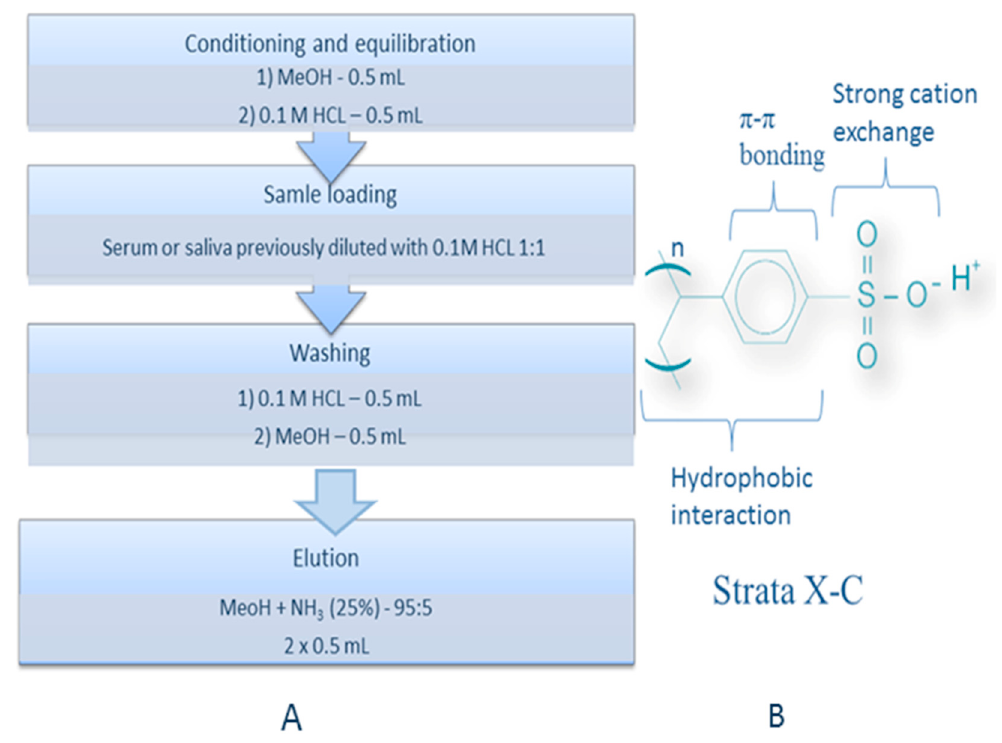
Figure 6. The scheme of the SPE procedure applied for the preparation of human serum and saliva samples ( A ) and scheme of Strata X-C phase with description of retention mechanisms ( B ).